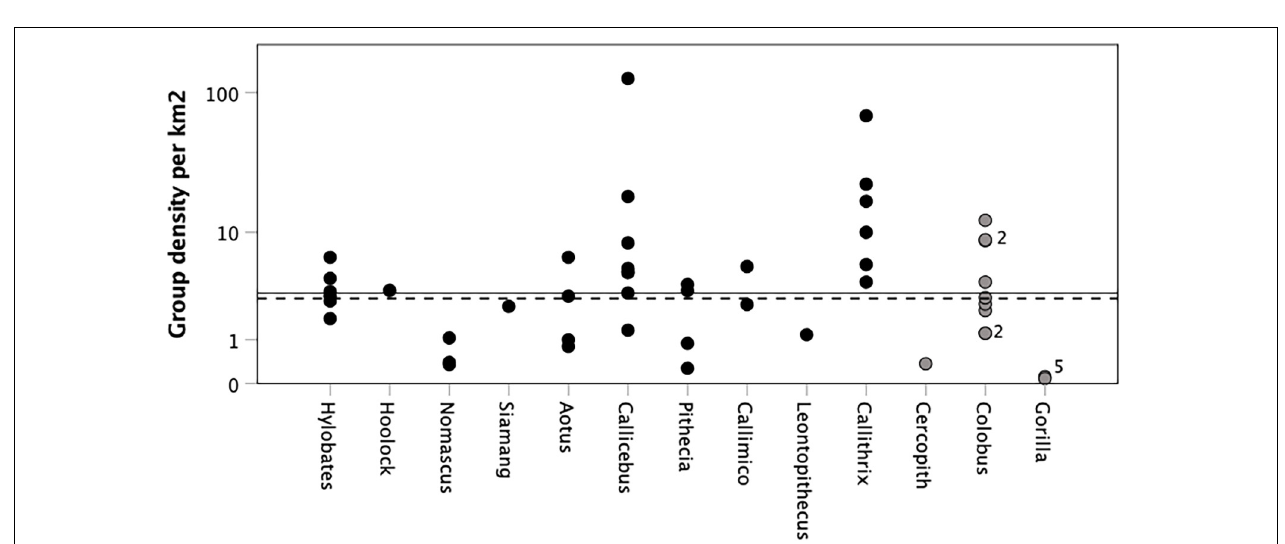
FIGURE 4 | Observed density of groups for monogamous genera, for individual populations. The solid line indicates the median value for the observed data; the dashed line indicates the median value estimated by the model (based only on day journey length and assuming no overlap of adjoining territories). The model does not overestimate the density of groups. Filled symbols: social or dispersed monogamous groups; grey symbols: stable polygynous groups. Multiple datapoints at the same position are indicated by the numbers adjacent to symbols. Y-axis is log 10